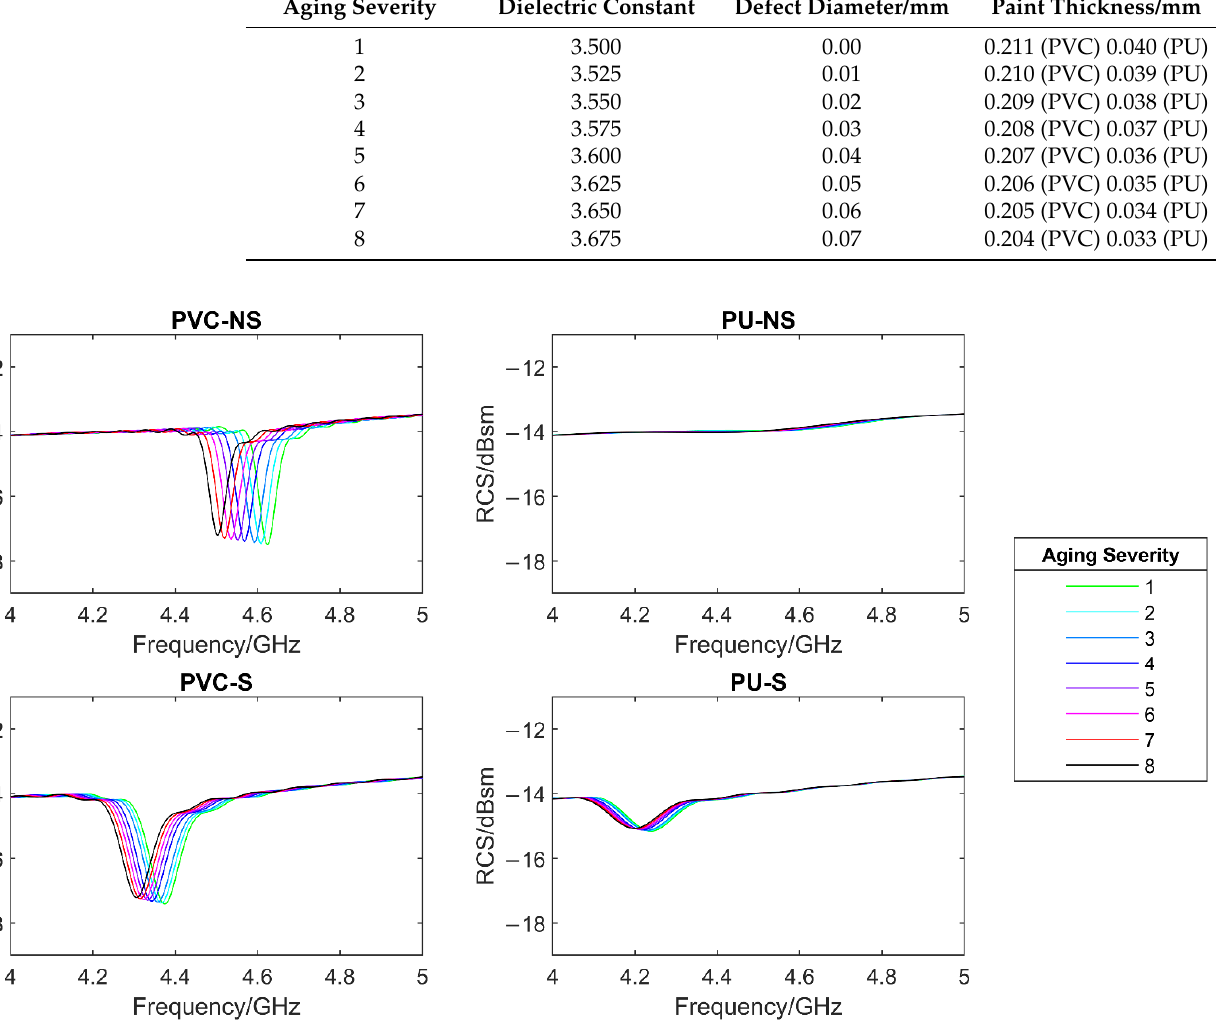
Figure 15. The effect of simulated aging on the resonant frequency ( left ) and the RCS at resonant frequency ( right ) of each system. 3.2. Experimental 3.2.1. Initial Test of the System Figure 16 shows the comparison between the simulated and measured RCS for both paint and mounting systems. This test was carried out on virgin, white coloured samples. It can be seen that interference was captured compared to the ideal simulated scenario. This made the detection of the resonant frequencies for the NS samples (no additional substrate) impossible to determine. However, the resonant frequencies of system two